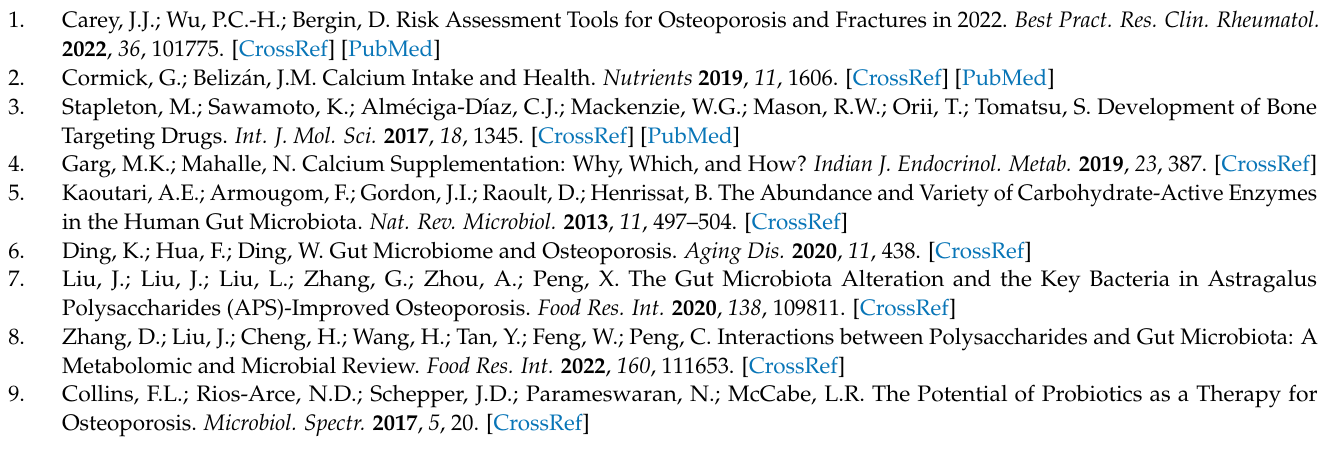
Figure S2: Body weight of rats in each